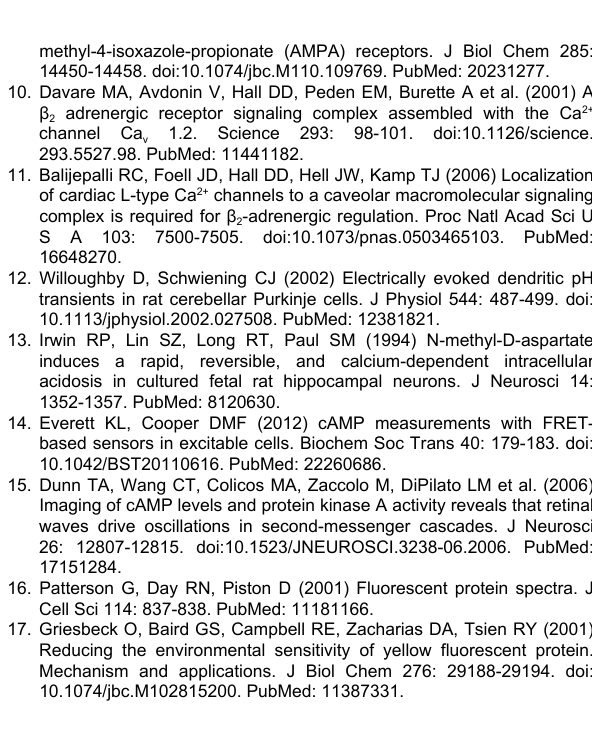
Figure S3. Single cell data for cAMP measurements in control, BAPTA-AM and EGTA-AM conditions. cAMP measurements in MIN6 cells expressing Ci/Ce Epac2-camps AC8 and depolarised with 20 mM KCl in the presence of 1.3 mM Ca 2+ . Traces represent individual cells from 8-10 independent experiments. ( A ) control conditions (n=20 cells) or pre-loaded for 30 min with ( B ) 30 µM BAPTA-AM (n=11 cells) or ( C ) 30 µM EGTA-AM (n=26 cells).